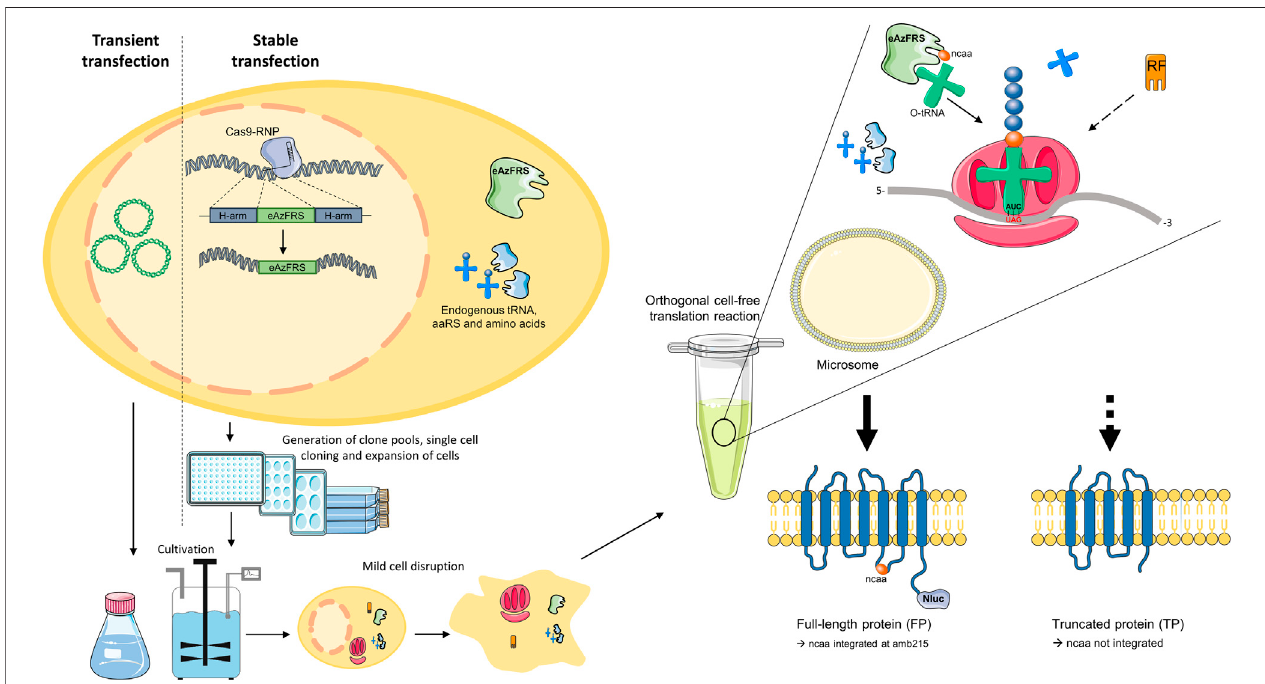
FIGURE 1 | General work fl ow. CHO cells were either transiently or stably transfected. While transiently transfected CHO cells were cultured in shake fl asks and bioreactors for two days, stable transfected cells were subjected to selection pressure to obtain clone pools and clonal cell lines. The adenosine A2a receptor, which is C-terminally coupled to a Nanoluciferase (Nluc), was used to evaluate the developed orthogonal modi fi cation system. In the presence of orthogonal eAzFRS and orthogonaltRNA (o-tRNA),aswellasthenon-canonicalaminoacid(ncaa) p-azido-L-phenylalanine,theamber stop codonUAG ataminoacidposition215canbe addressed to produce amber suppressed full-length protein (FP). Upon binding of the eukaryotic release factor (RF) termination product (TP) will be produced. Arrows indicate the direction of the work fl ow. The dashed arrow indicates translation termination. Parts of the fi gure were created by using pictures from Servier Medical Art (http://smart.servier.com/). Servier Medical Art by Servier is licensed under a Creative Commons Attribution 3.0 Unported